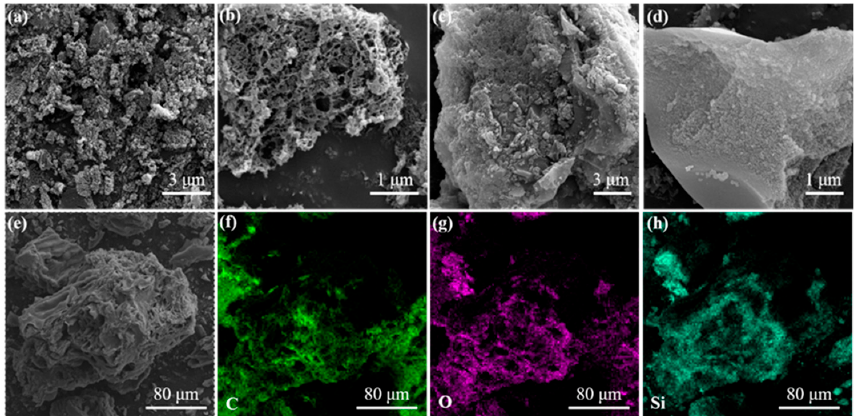
Figure 5. SEM images of ( a , b ) GL and ( c – e ) GL-TEOS, and the corresponding EDX mapping of ( f ) C, ( g ) O, and ( h ) Si.